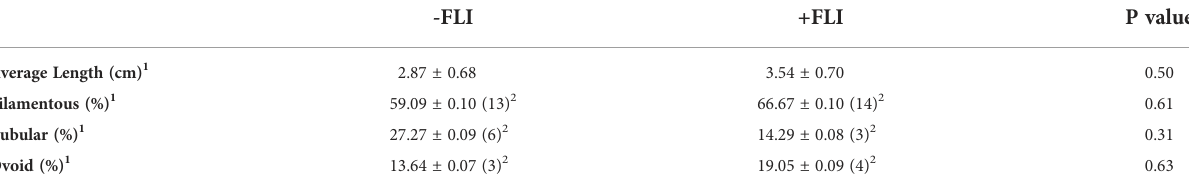
TABLE 2 Length of all recovered conceptuses and number recovered in each classi fi cation.